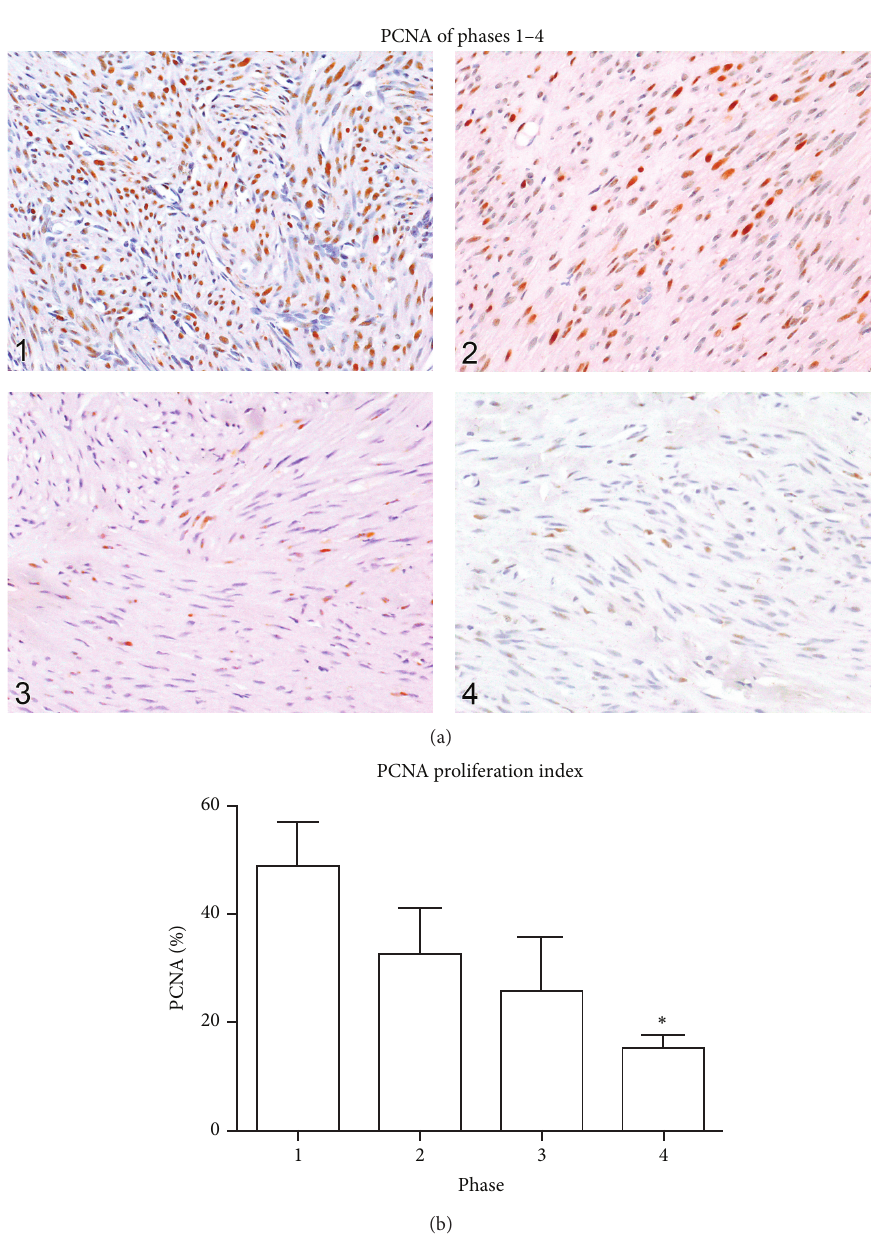
Figure 3: Fibroid phases: comparison of PCNA staining. (a) In this panel, a representative image of PCNA immunostaining from a fibroid in each of the four phases is shown. The percentage of PCNA positive nuclei in areas of maximum staining within the 4 fibroids in this panel was 59.1, 25.3, 19.1, and 15.5 for phases 1, 2, 3, and 4, respectively. A few PCNA positive nuclei are present in the phase 4 photo, but these are less intensely stained and thus less obvious than those in the other phases. All images were taken with the 20x objective. (b) Bar graph of Mean PCNAs from each phase. Although there was significant variation of PCNA scores within each phase of tumors in this study, as noted in Table 1, the mean scores of each phase declined progressively from phase 1 to phase 4. There were 5 samples per phase group and the values represent the mean ± SEM. ∗ Significantly different from phase 1 ( 𝑃 < 0.01 ).